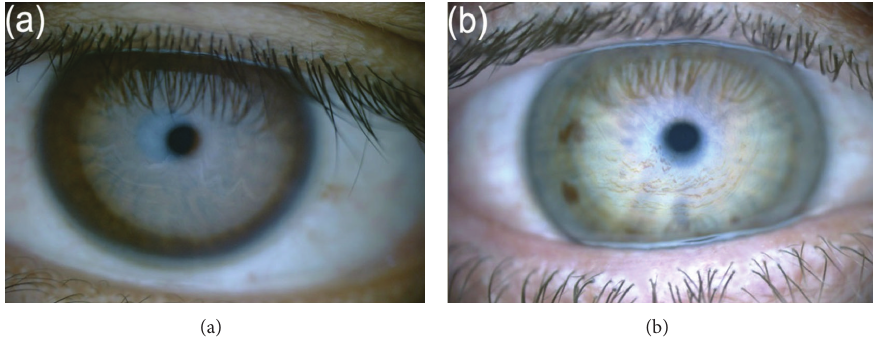
Figure 1: Representative examples of tear film—lipid layer grades: (a) grade 3: wave pattern; (b) grade 5: colour fringe